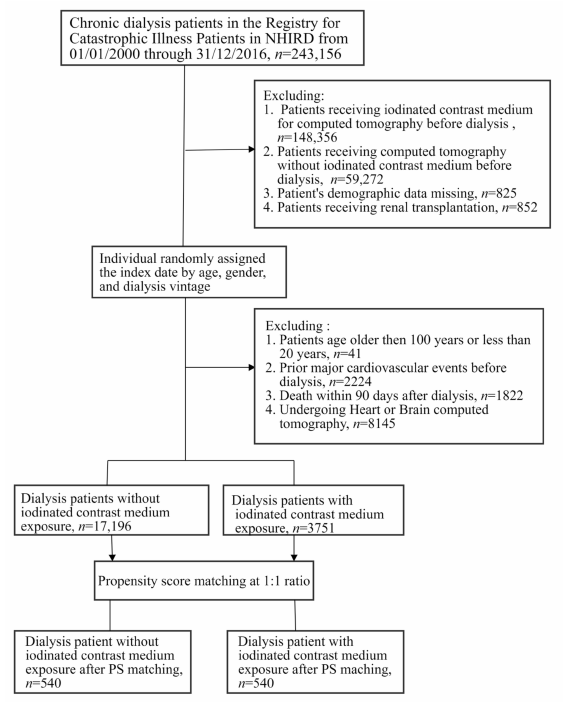
Figure 1. Study design and patient selection